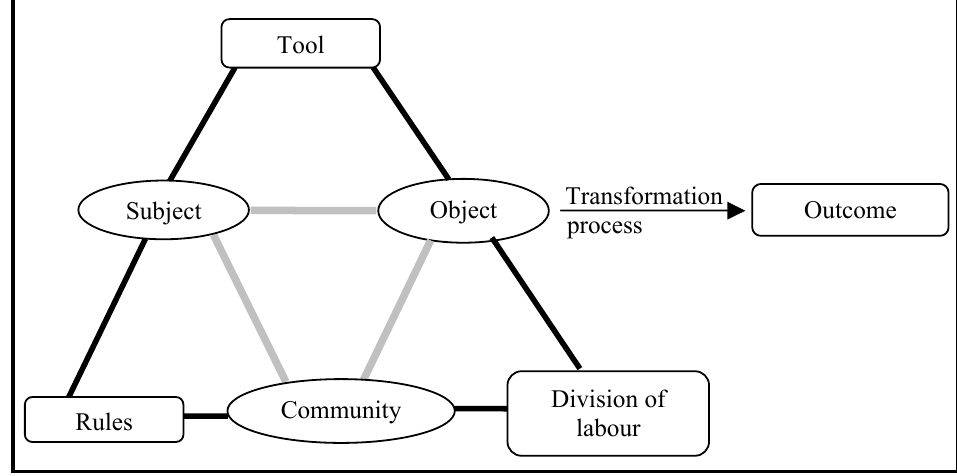
Figure 1. Engeström’s expansion of activity